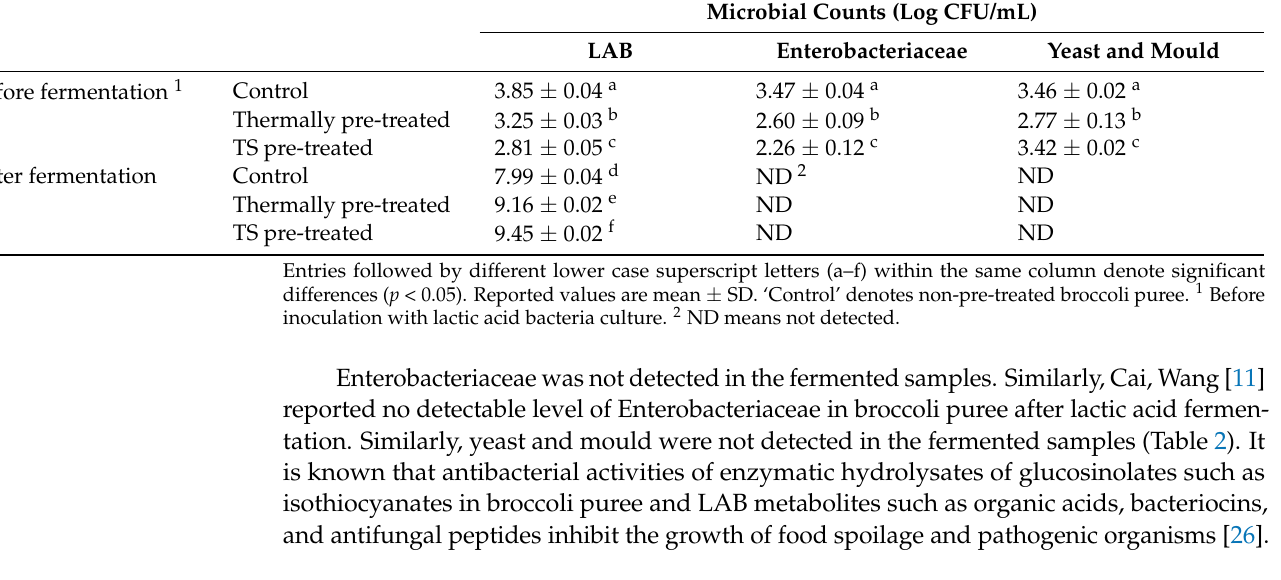
Table 2. Effects of thermal or thermosonication treatments of broccoli florets on microbial load of broccoli purees before and after lactic acid fermentation. Microbial Counts (Log CFU/mL) LAB Enterobacteriaceae Yeast and